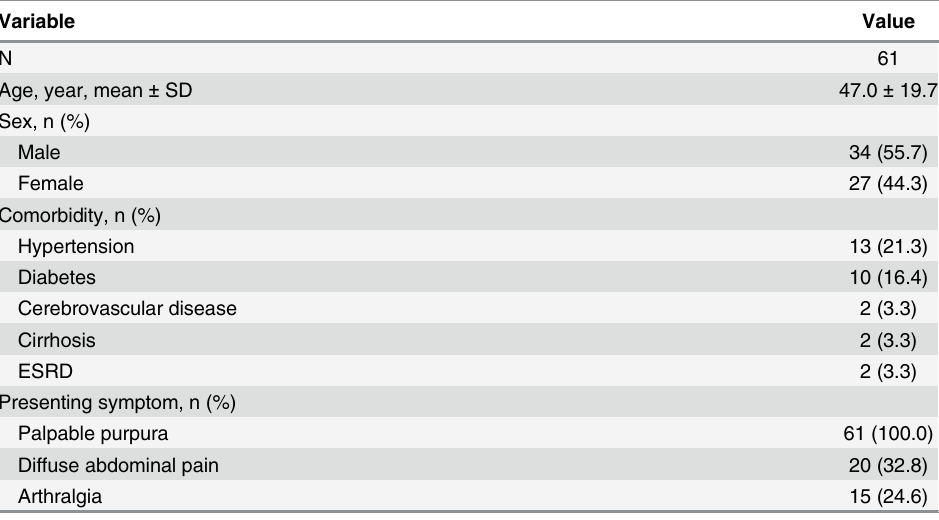
Table 1. Baseline characteristics of the enrolled